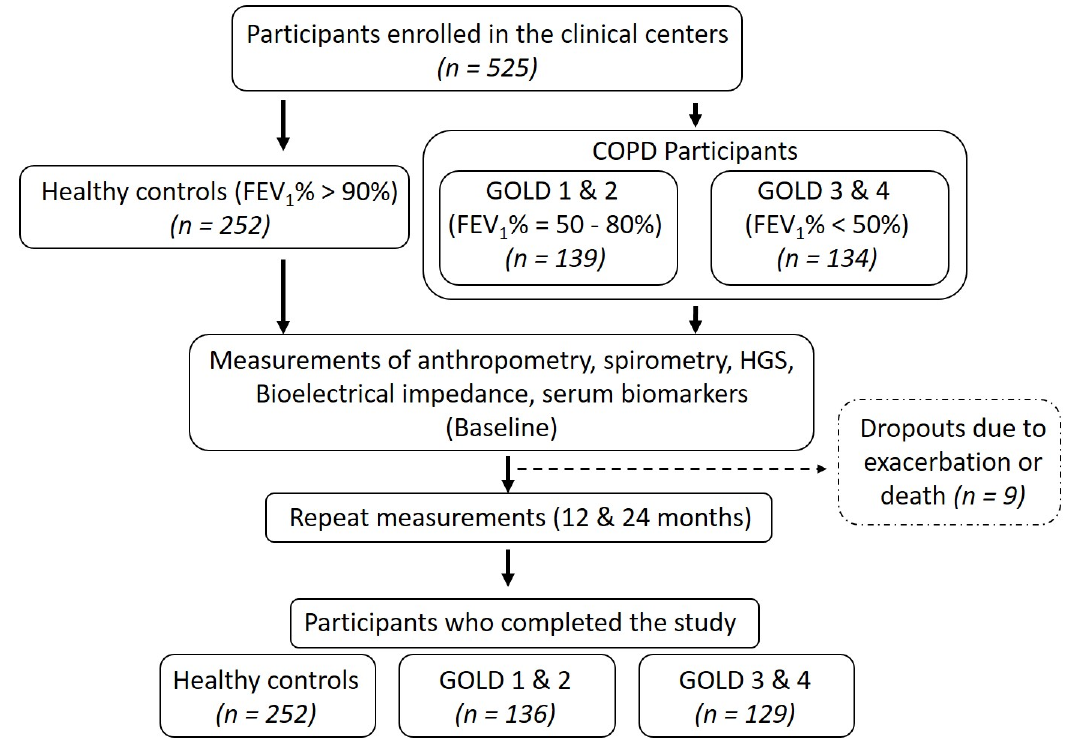
Figure 1. Study flow. FEV 1 %: Forced expiratory volume in the first second and GOLD: global initiative for obstructive lung diseases.